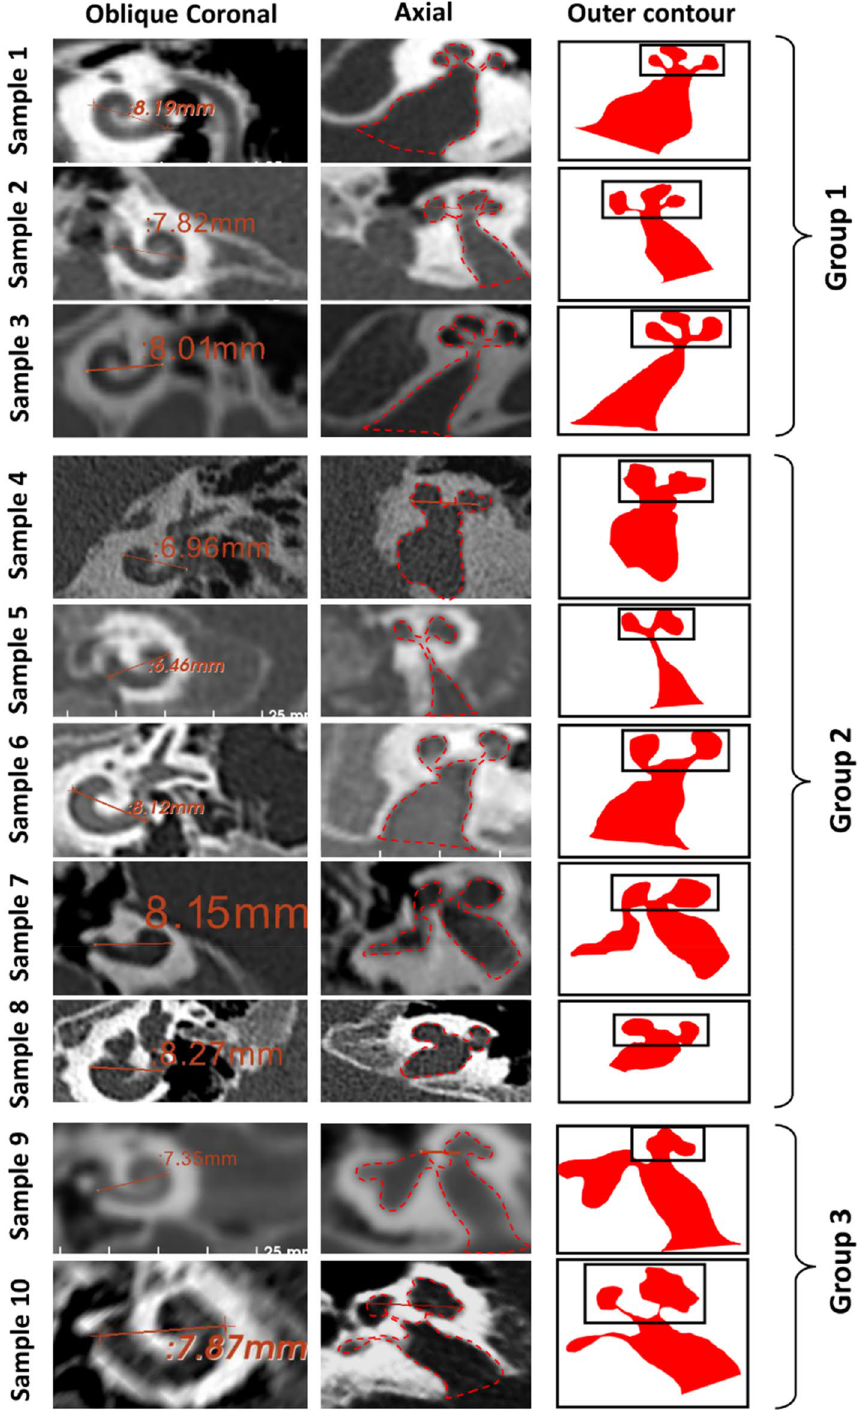
Figure 8. Cochlear hypoplasia (CH) type malformation shows a huge variation in the size, shape, and the availability of cochlear and vestibular portion. The outer contour of the mid-modiolar sections of the ten samples were brought under three groups. The outer contour of group 1 resembles a maple leaf, group 2 resembles a distorted dumbbell and the group 3 shows no close resemblance to any familiar